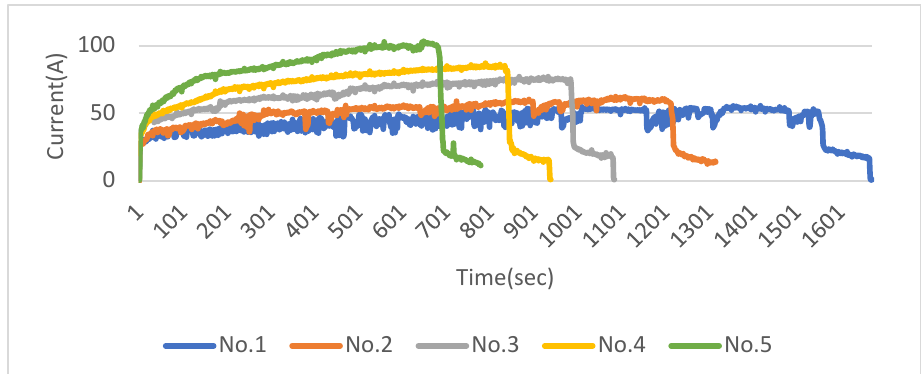
Figure 4. Current value of the five experiments of ECM